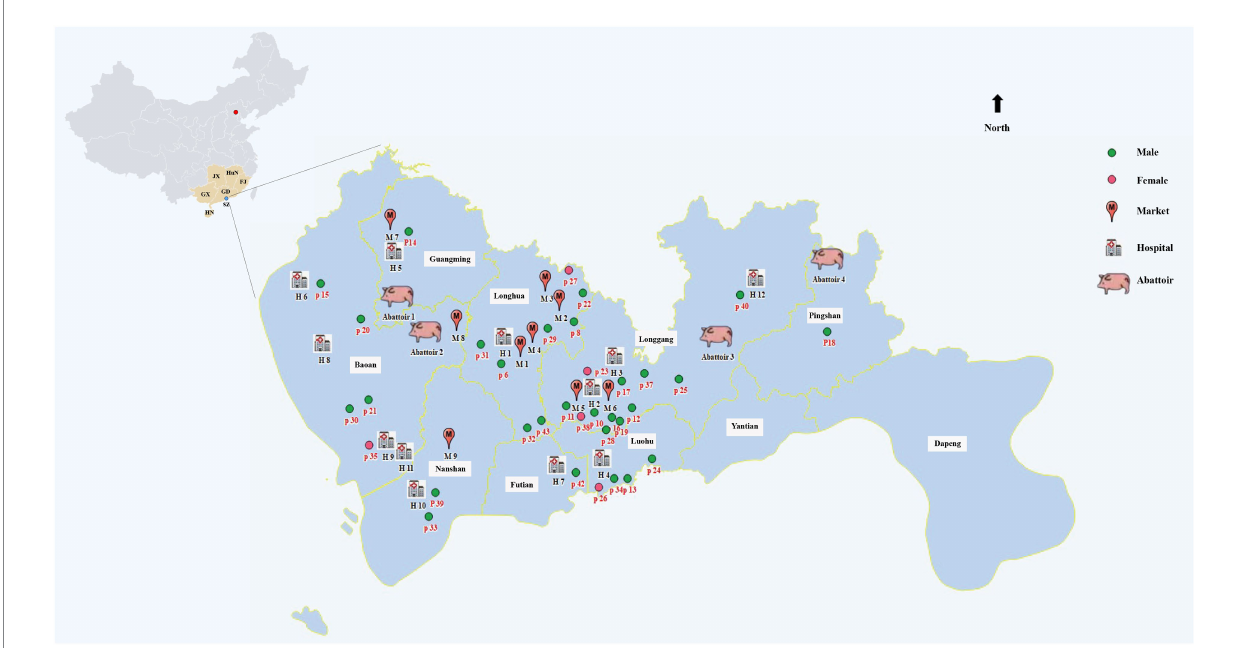
FIGURE 4 Map of domestic sources of pork and the distribution of human cases of S. suis in Shenzhen, China. The orange area of the map of China (left) represents the source of pork imports to Shenzhen. The letters indicate the provinces of China: GX = Guangxi; HuN = Hunan; JX = Jiangxi; FJ = Fujian; GD = Guangdong; HN = Hainan; SZ = Shenzhen. The blue area (right) is an expanded representation of the Shenzhen region. The circles in the figure represent the distribution of cases in each district of